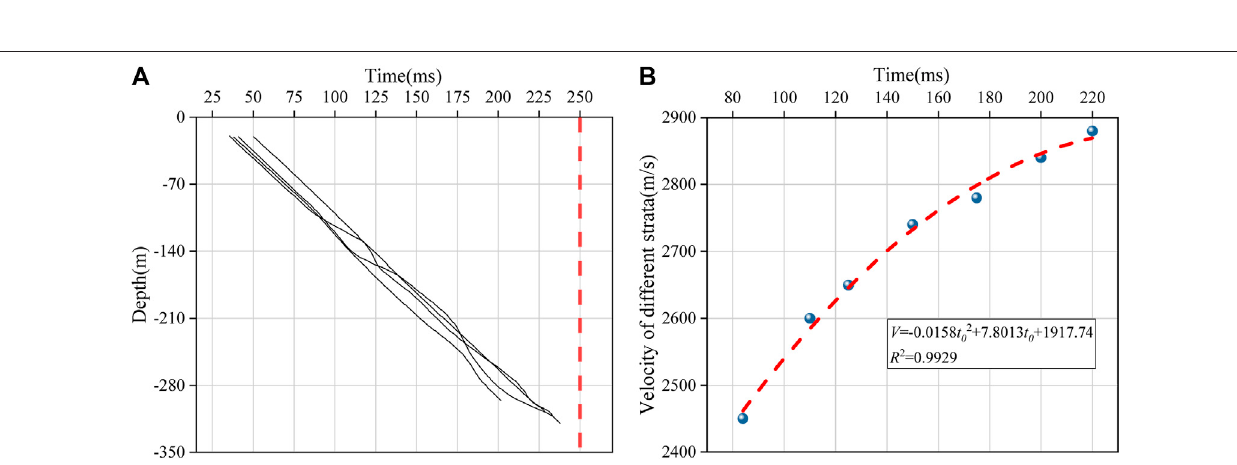
Frontiers in Earth Science |